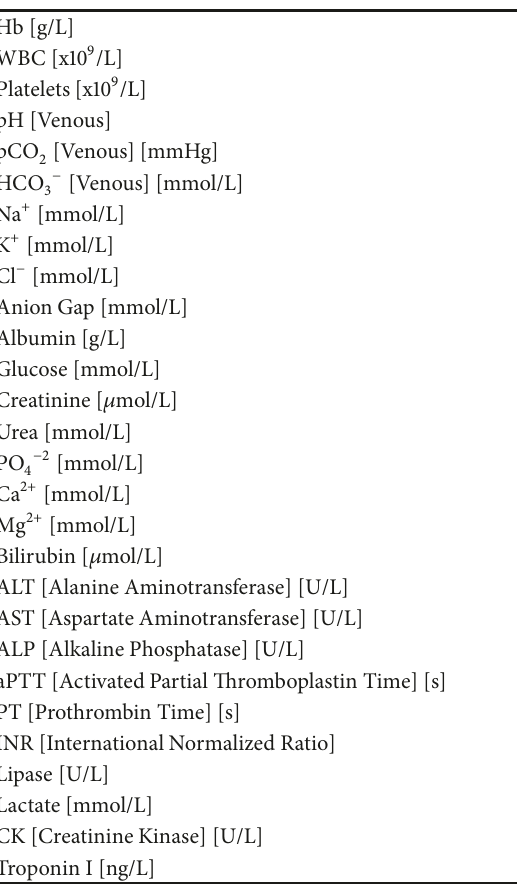
Table 1: Initial laboratory results [normal values in parentheses].